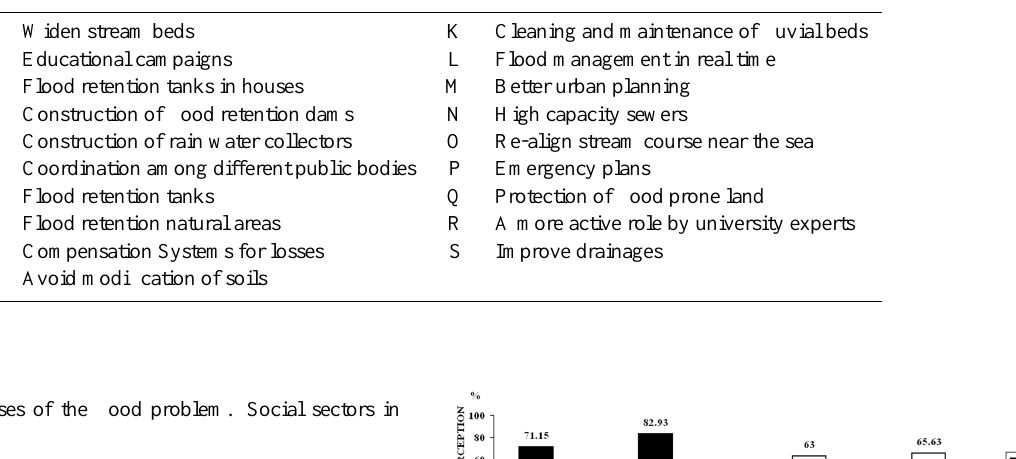
Table 4. Management options cited by social sectors in Focus Group sessions (respect to Fig. 13).